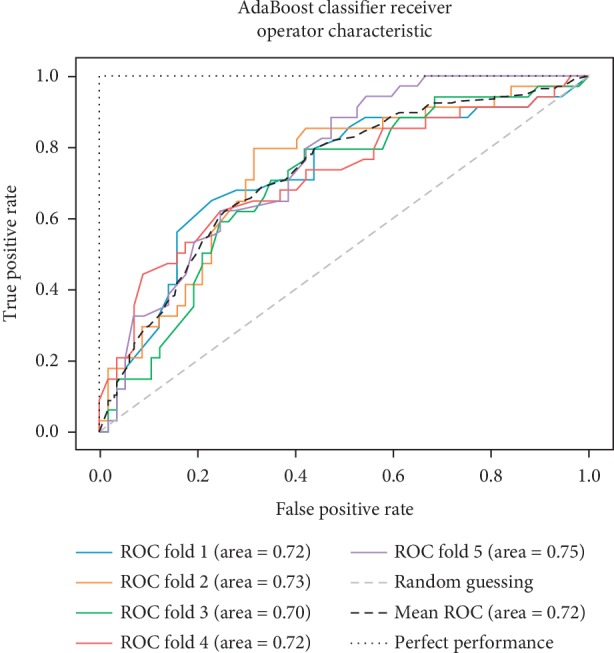
ROC curve for AB.